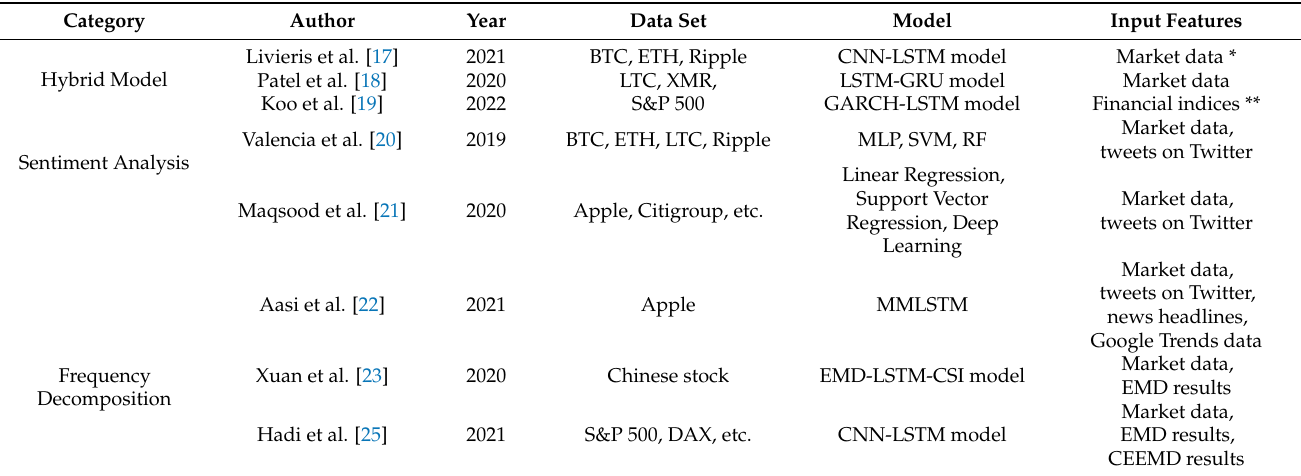
Table 1. Summary of related